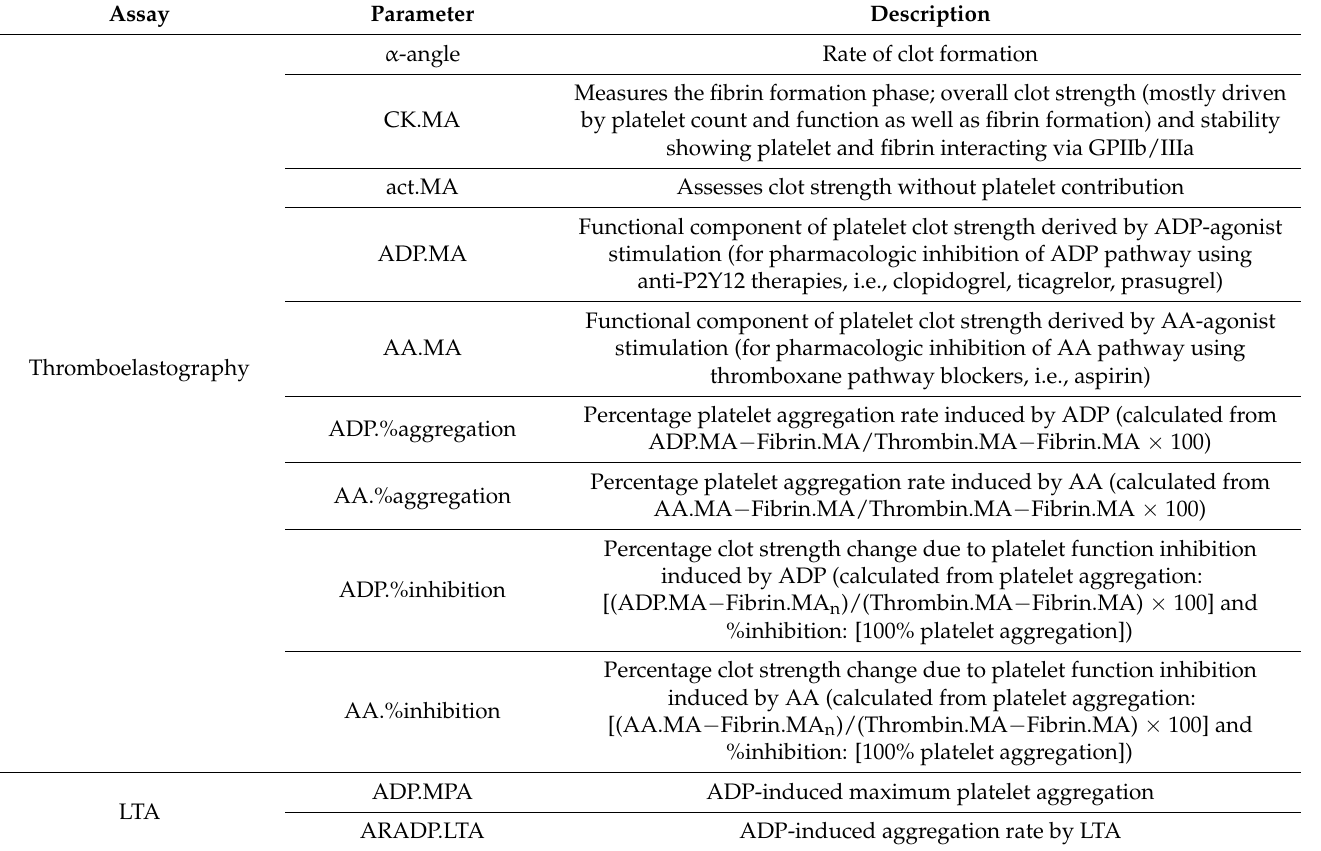
Table 2. Descriptions of platelet function/hemostatic